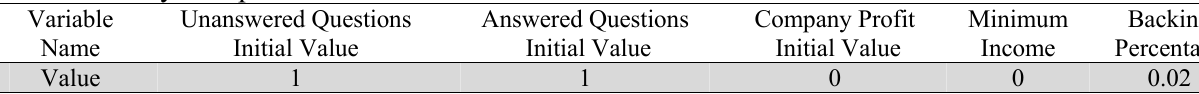
The summary of input